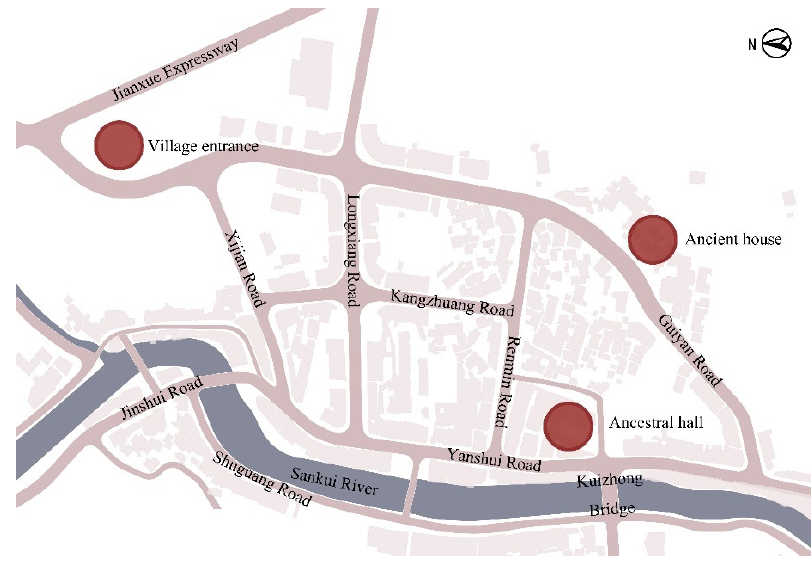
Figure 5. Current situation of the centre in Sankui Town.